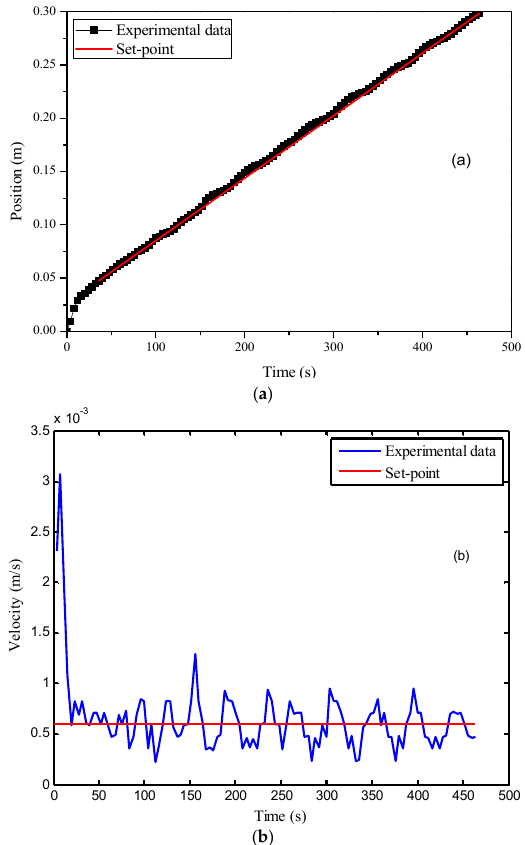
Figure 7. Control results of the PI (proportional–integral) controller: ( a ) time vs. flow front position; ( b ) time vs. flow front velocity.